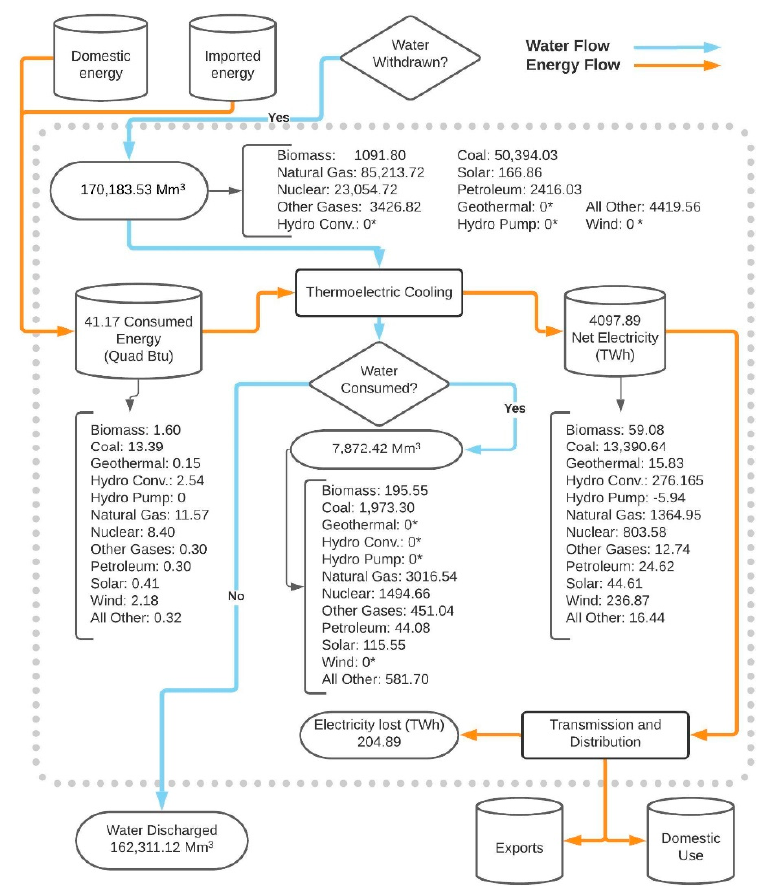
Figure 2. Annual average energy (Quad Btu and TWh) and water flow (Mm 3 ) by energy source for electricity production in the US 2014–2019. The grey dashed line represents the boundary of our model, which is limited to electricity generation at the plant scale. Orange lines represent energy consumed and electricity produced, and blue lines represent water use in thermoelectric cooling. The * denotes where water use is not reported by power plants to EIA and is assumed as zero.